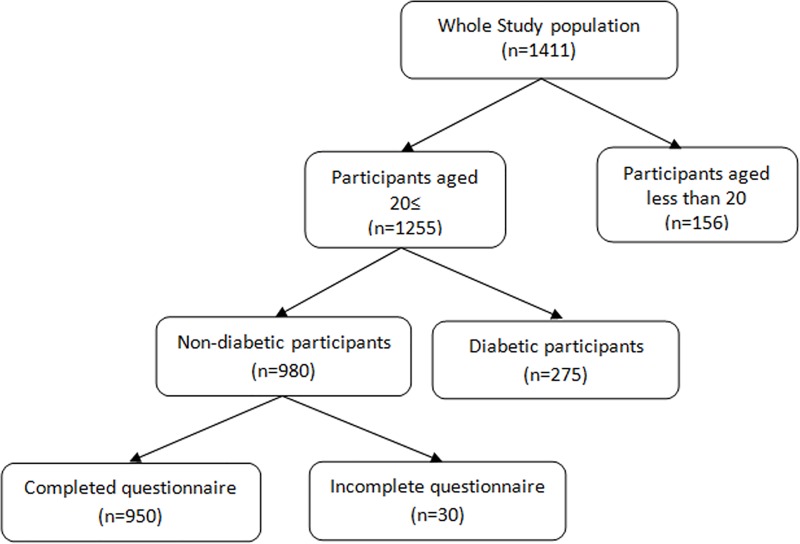
The sampling frame of the study.